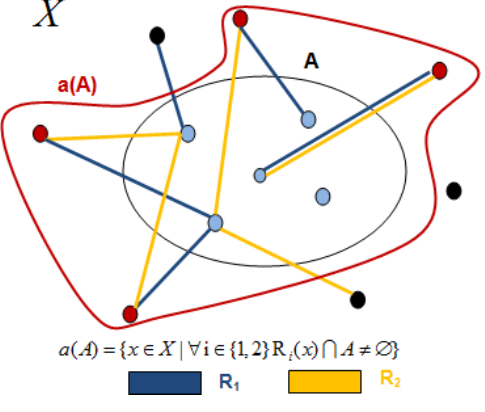
Fig. 3. Pseudo-closure of A in a binary